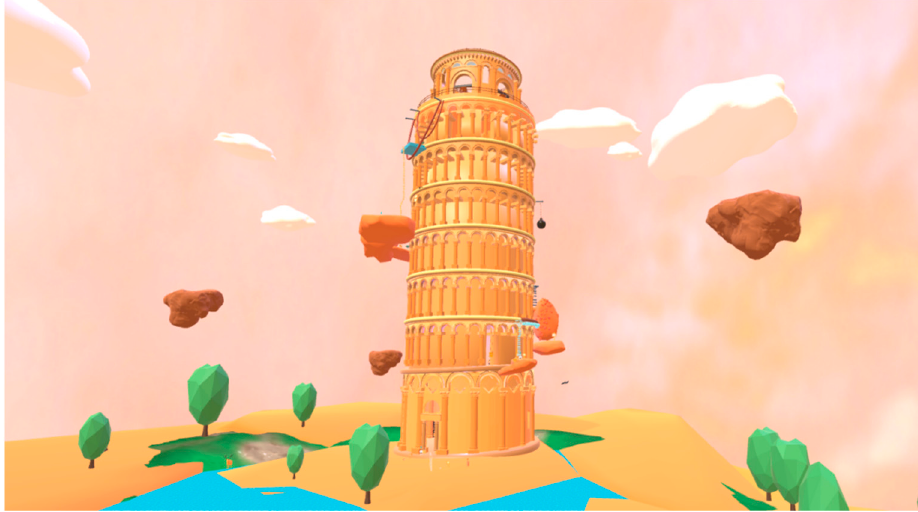
Figure 3. The climbing scene of the Leaning Tower of Pisa.